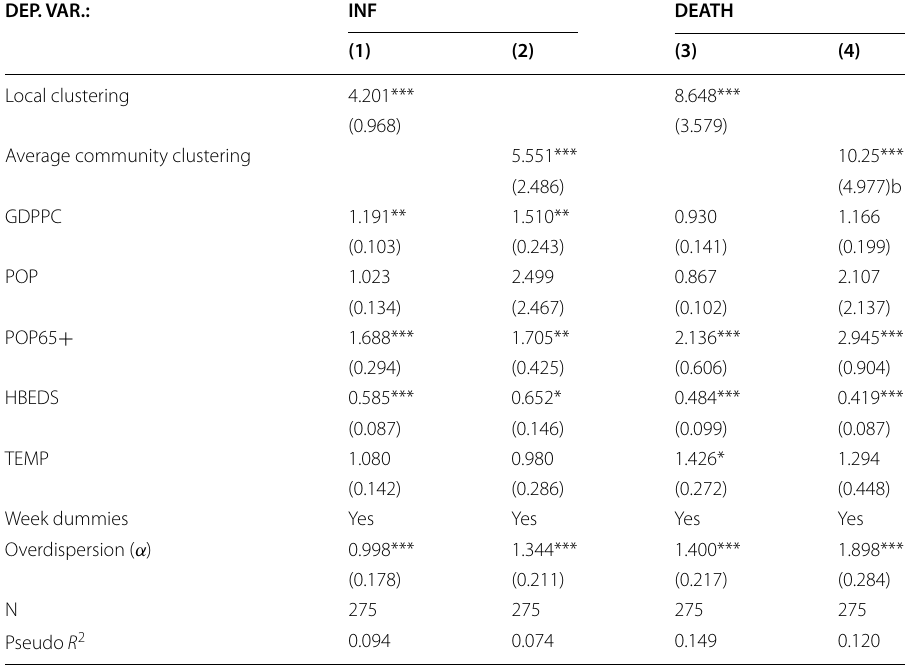
Country‑level clustered standard errors in parentheses.